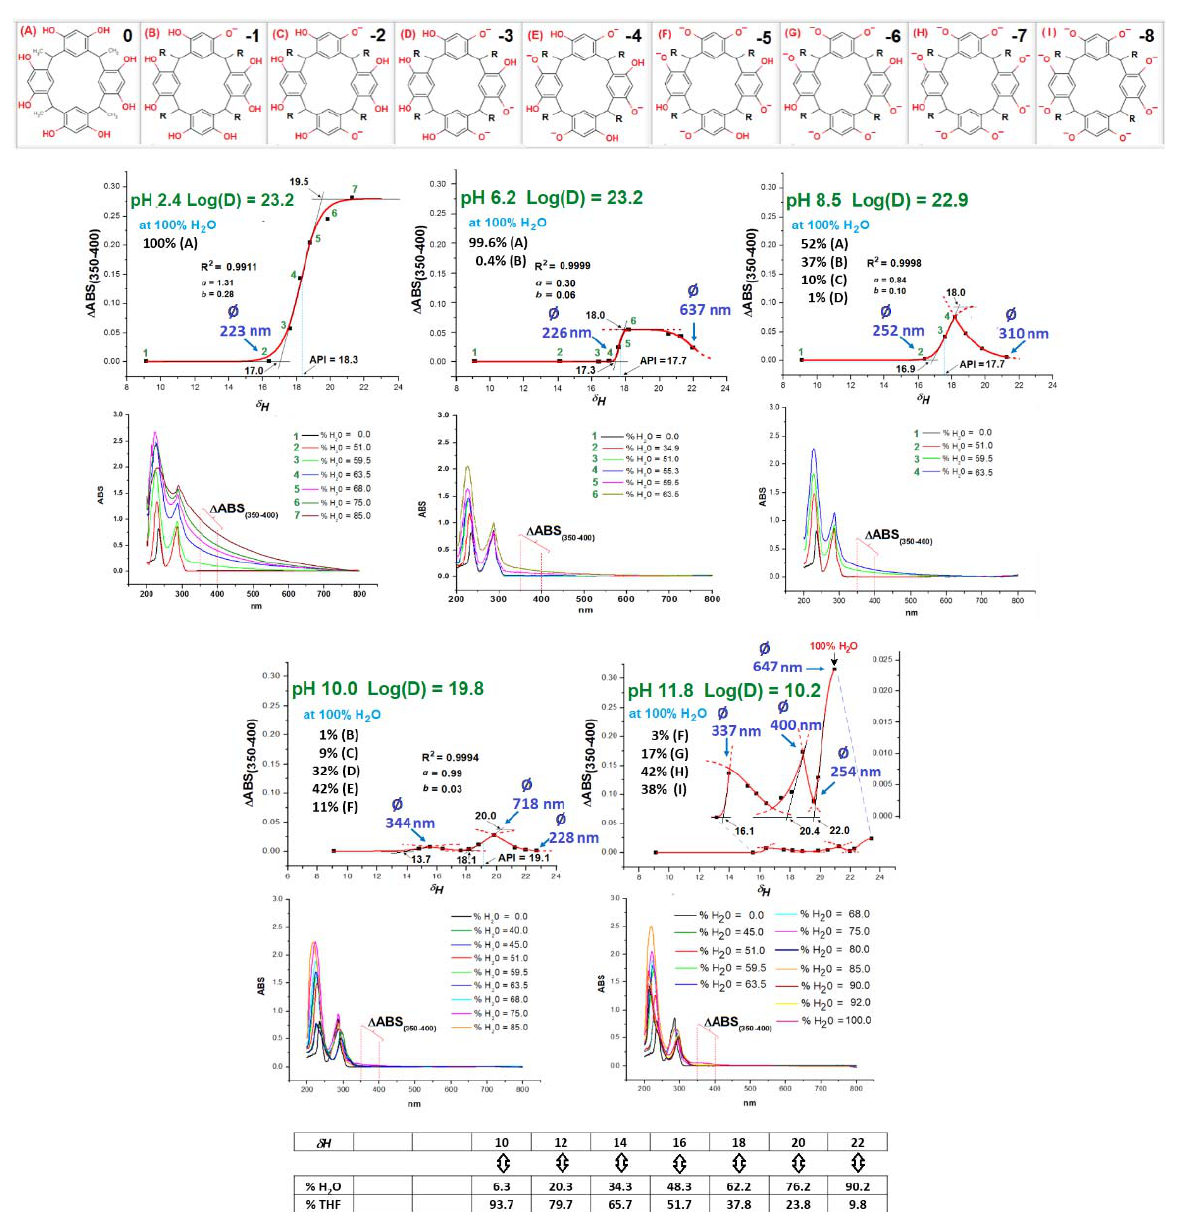
Figure 8. The sigmoidal aggregation profiles and the corresponding UV-visible spectra of resorc[4]arene R3 as obtained in THF/water solvent systems at fixed pH values of the aqueous component. Regression analysis to fit the experimental data was performed according to Equation (2). Subfigures ( A – I ) represent the deprotonation states of R3 at the analyzed pH values of 2.4, 6.2, 8.5, 10.0 and 11.8 (the relevant percentages are shown next to the respective aggregation plots).